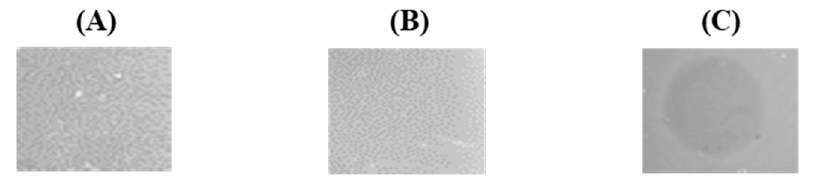
Figure 5. Immunity assay of E . faecalis JH2-2 transformants. E . faecalis JH2-2 transformants harboring pF49-I ( A ), pF49-TABCI ( B ), and empty pMG36c vector (( C ), negative control) were tested for tolerance to enterocin F4-9 by the spot-on-lawn assay. The culture supernatant of E . faecalis F4-9 was used for enterocin F4-9 preparation.